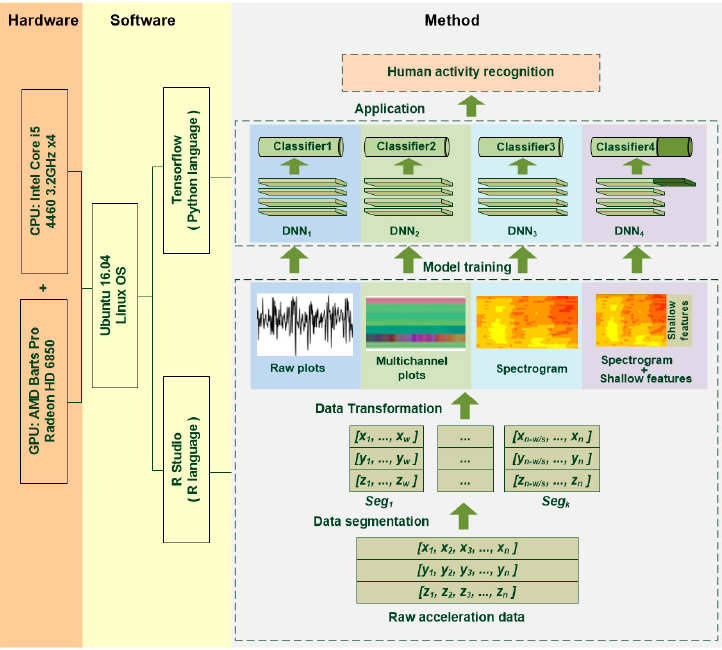
Figure 1. Framework of the proposed method.